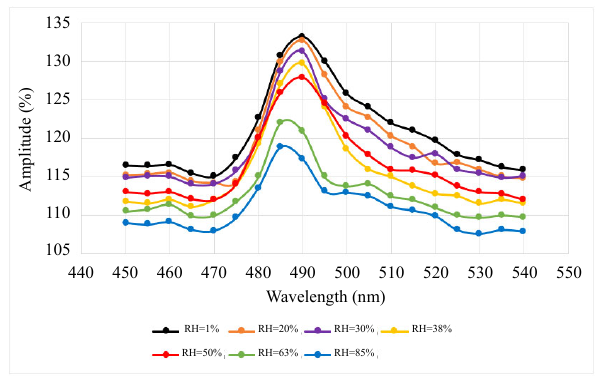
Fig. 7 Backscattered signals under different